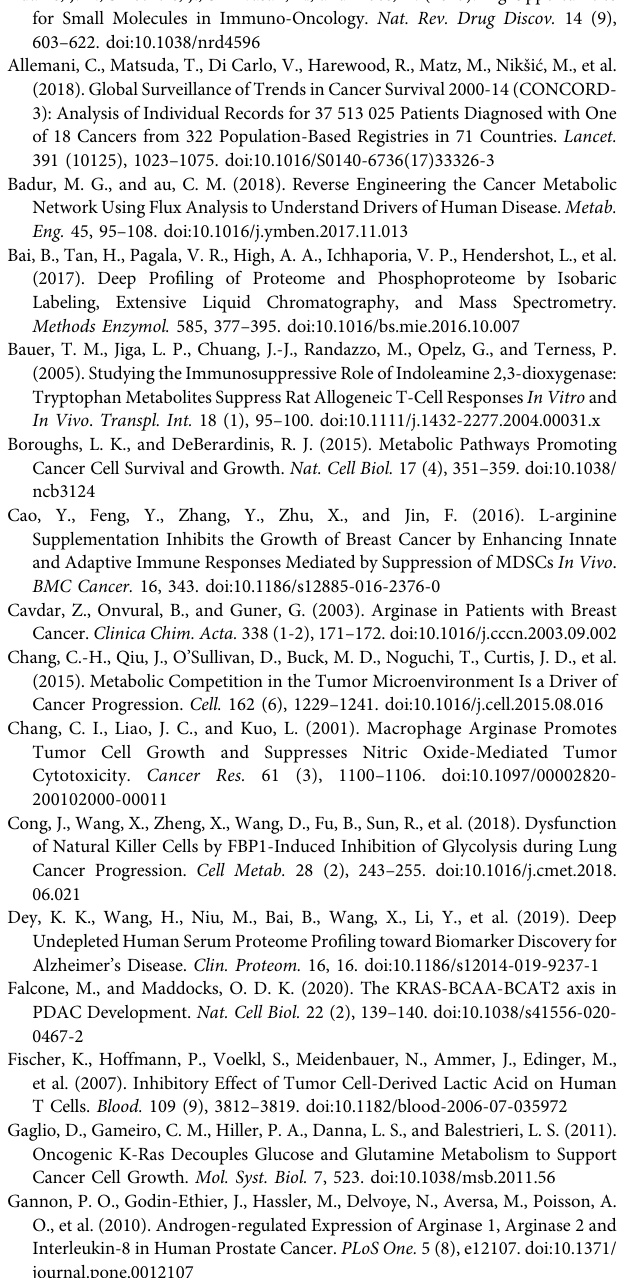
Supplementary Figure S1 | (A) Plot of correlation analysis of proteomics and transcriptomics between GC and normal gastric samples. The green point represents a protein (mRNA) with signi fi cant difference in expression, and the blue point represents a protein (mRNA) without signi fi cant difference in expression. Log 2 (FC) was used for calculation of protein (mRNA) expression. (B) Venn plot of the transcriptome and proteome between the GC and normal gastric samples. all_Tran represents all genes from the transcriptome, diff_Tran represents differentially expressed mRNAs identi fi ed by the transcriptome, all_Prot represents all proteins identi fi ed by the proteome, and diff_Prot represents the